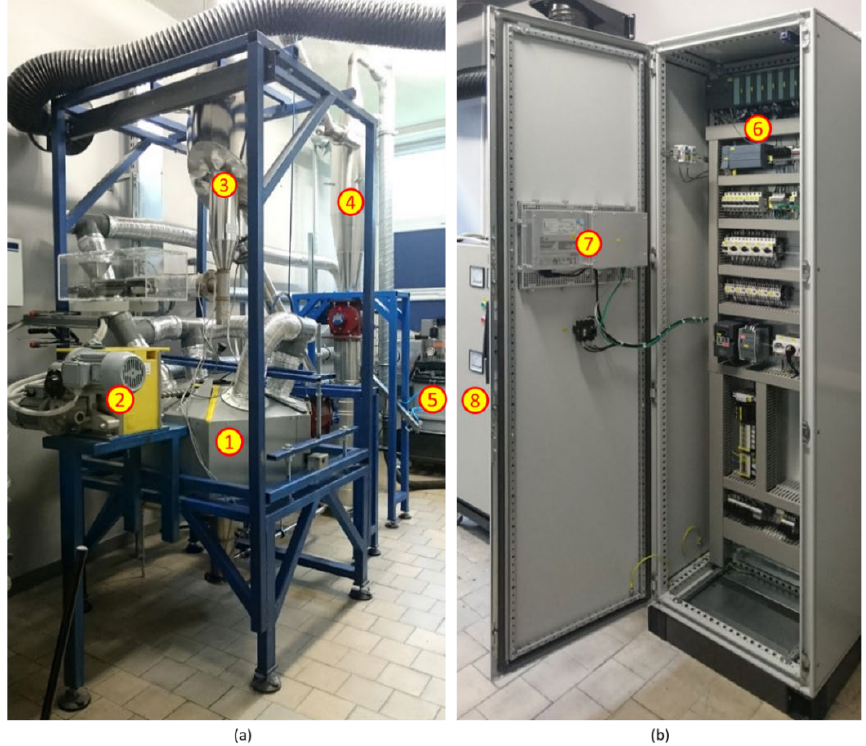
Figure 2. Semi-industrial dry grinding and classification circuit with EMM D100: ( a ) installation with air transport and heat recovery systems; ( b ) control and power supply cabinets.